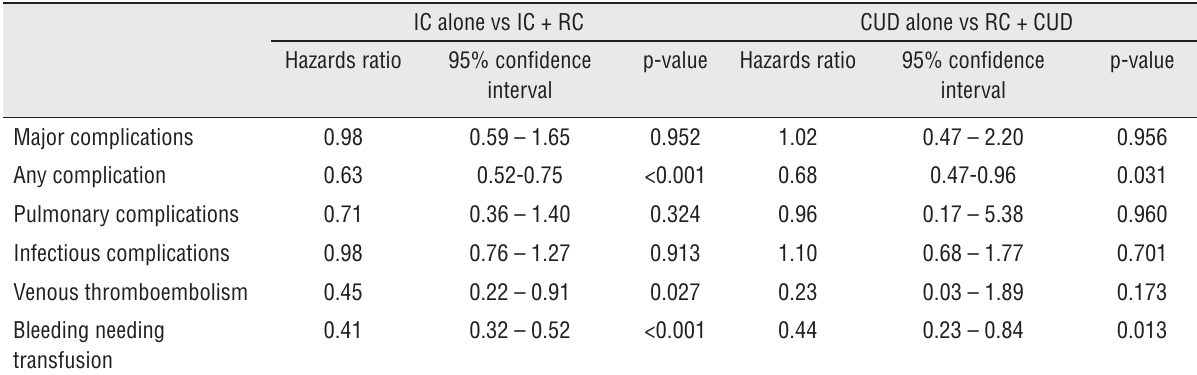
Supplemental Table 2 - Association of RC with complications compared to urinary diversion